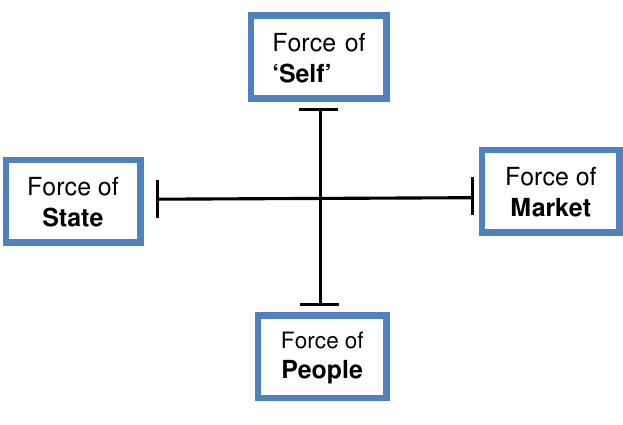
Fig. 1 - Model of Holistic Globalization (Source: Sharma (2010), ‘Beyond Pyramid and Pyramid Thinking: Pyramid vs Coconut model of Thinking’)